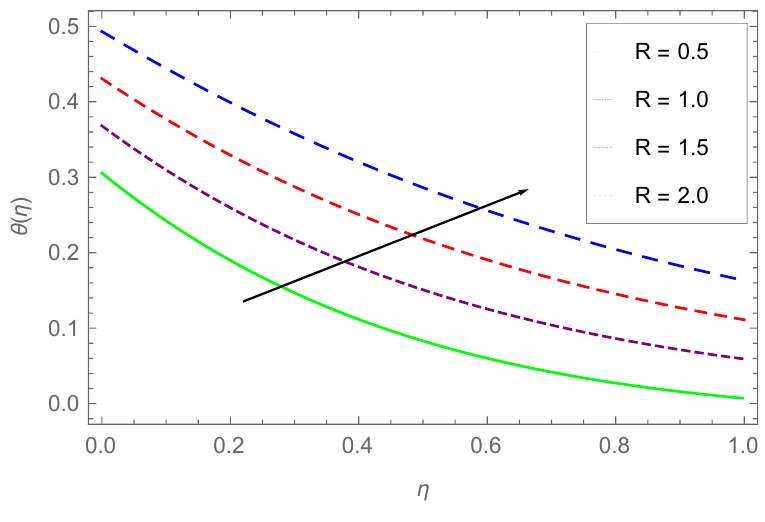
Figure 9. Impact of R over θ ( η ) .